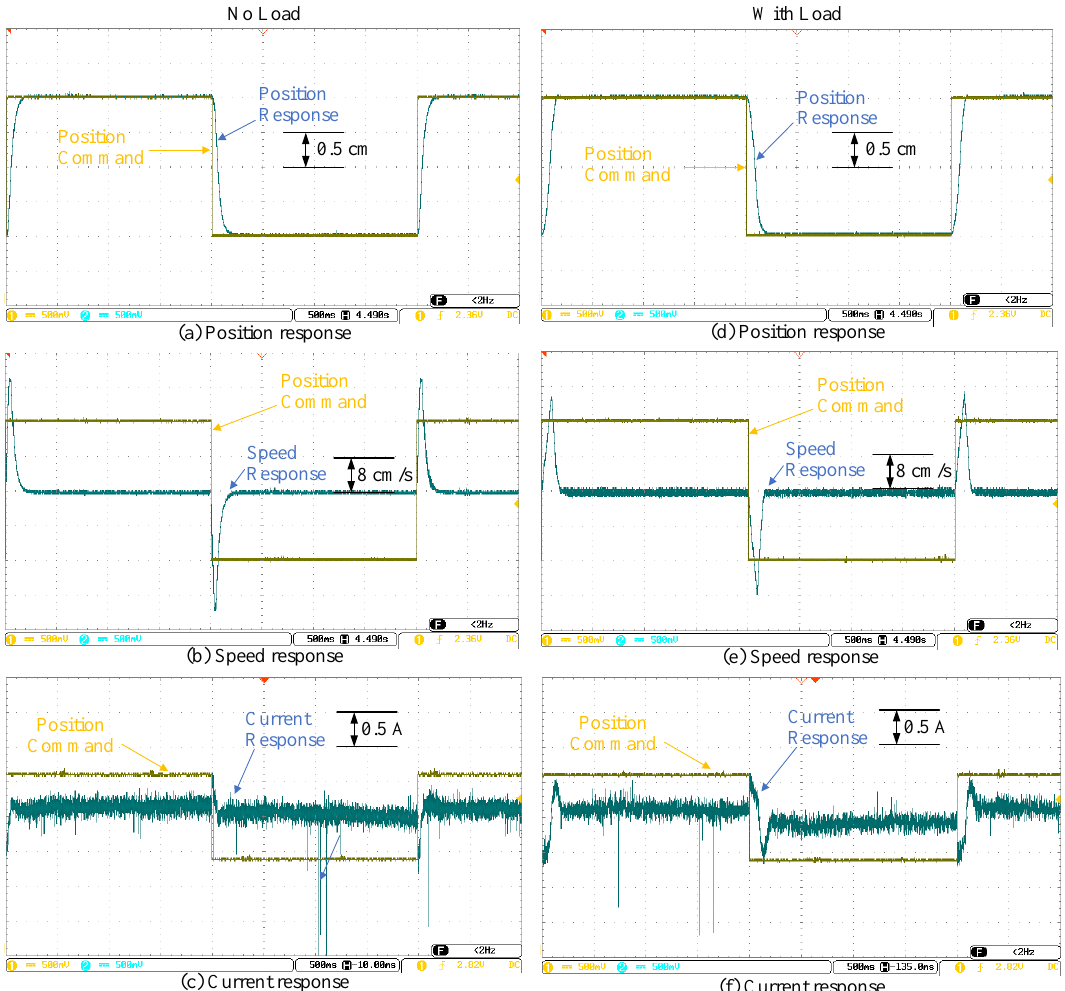
Figure 8. The experimental results of no load and with load.